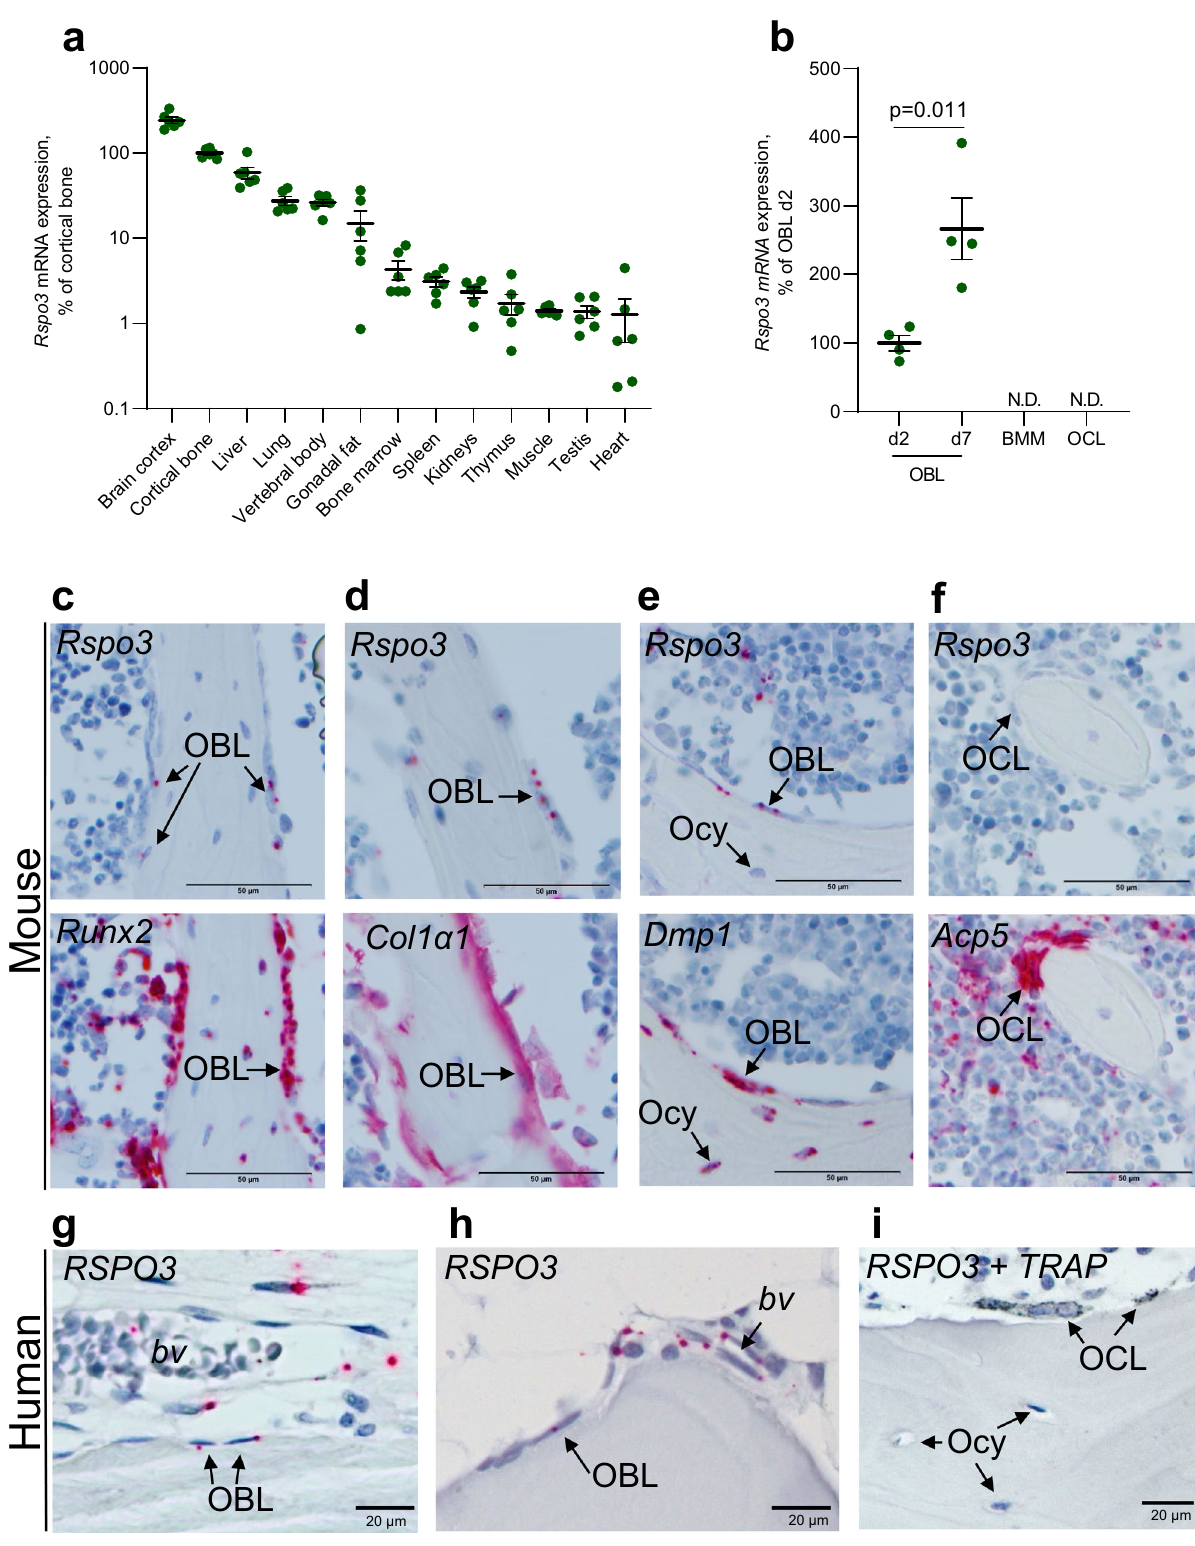
(Fig. 3a) 42 . Runx2-creRspo3 fl ox/ fl ox mice had more than 90% reduced Rspo3 mRNA levels in both vertebral trabecular